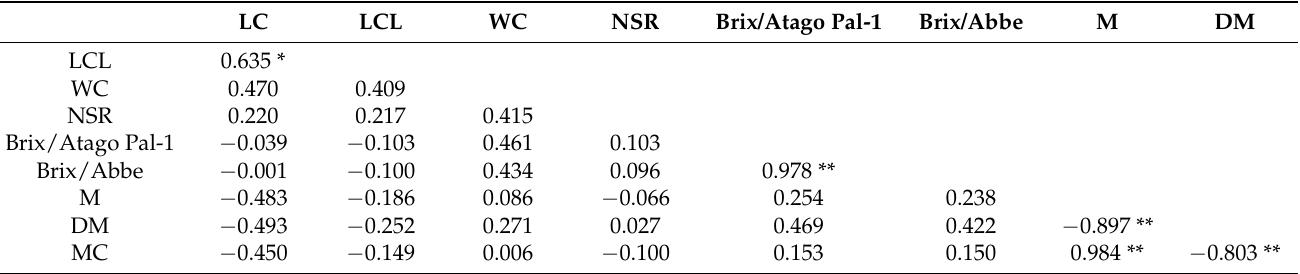
Table 3. Correlation of parameters in different irrigation treatments with different maize